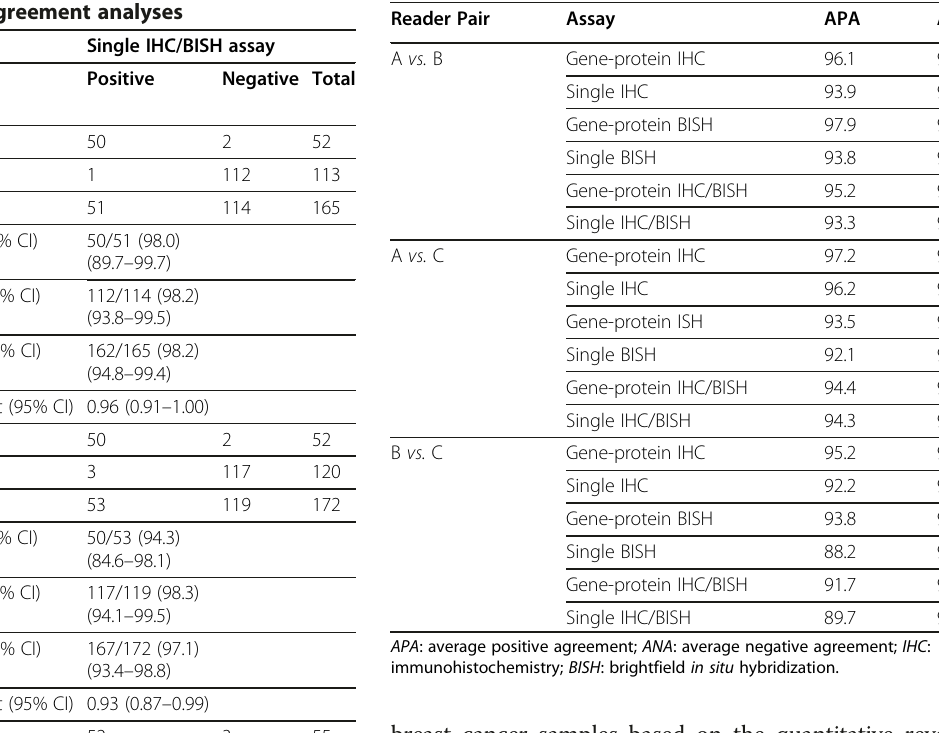
Table 9 Inter-reader agreement by reader pair and